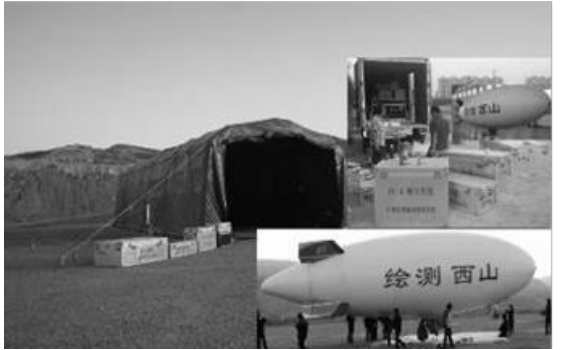
Figure 4. low altitude aerial unmanned airship system